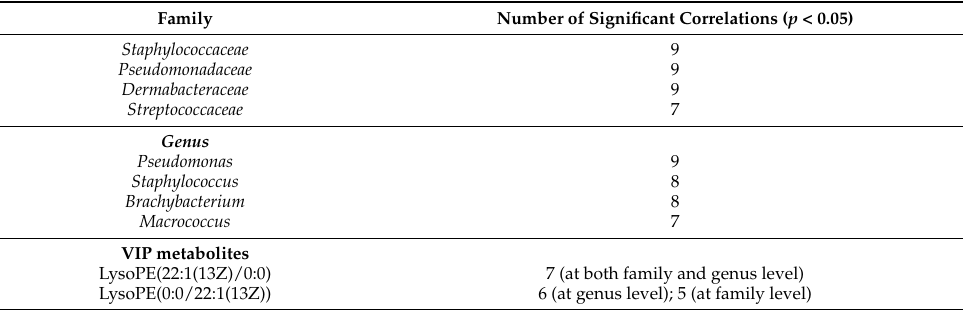
Table 2. Number of significant correlations established by bacterial families and genera with the